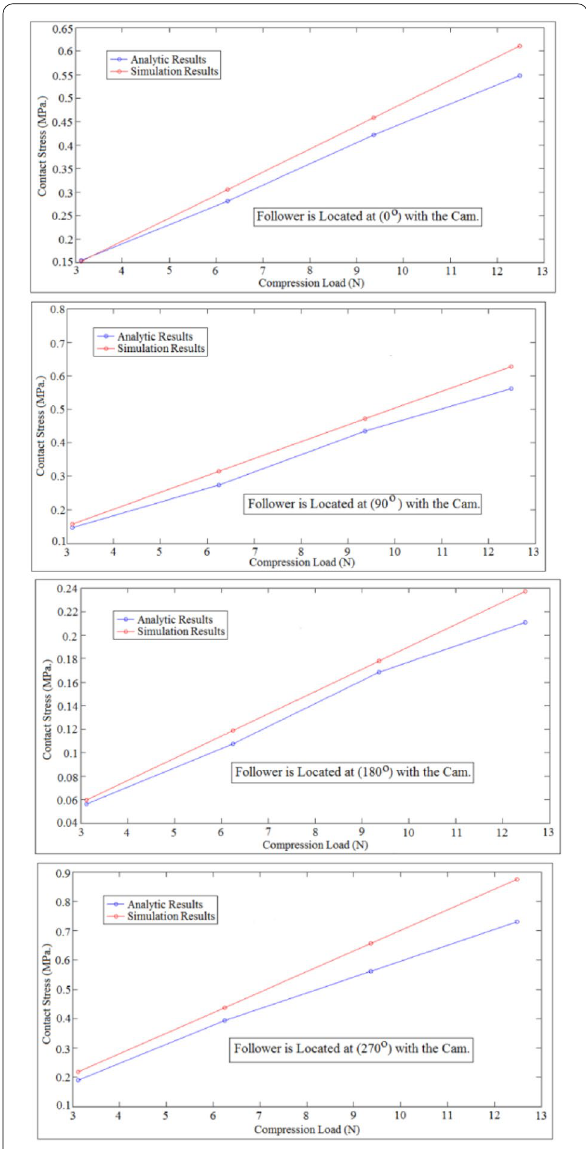
Figure 25 Verification of contact stress when the follower located at 0° and 90°, 180°, and 270° with the cam profile